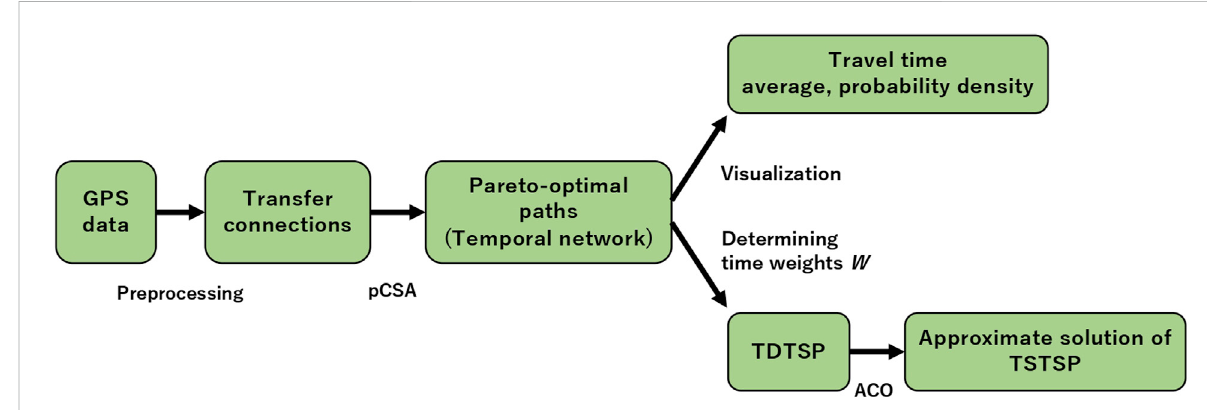
FIGURE 3 Research fl owofmobilityanalysisusingtemporalnetworks(top)andatravelroutesearchusingmeta-heuristics(bottom).The fl owremainsthe same until the GPS data are preprocessed, and the optimal set of paths is formed using the pCSA. In the mobility analysis using temporal networks, a set of optimal paths is visualized in an analyzable form. In a travel route search using meta-heuristics, a set of optimal paths is used to determine the